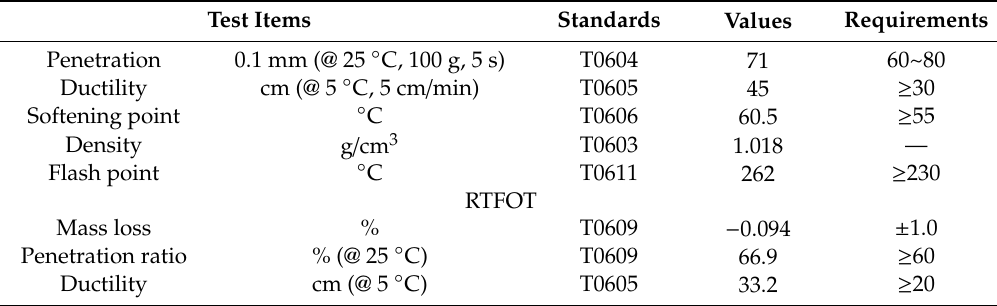
Table 1. Technical properties of SBS-modified asphalt.